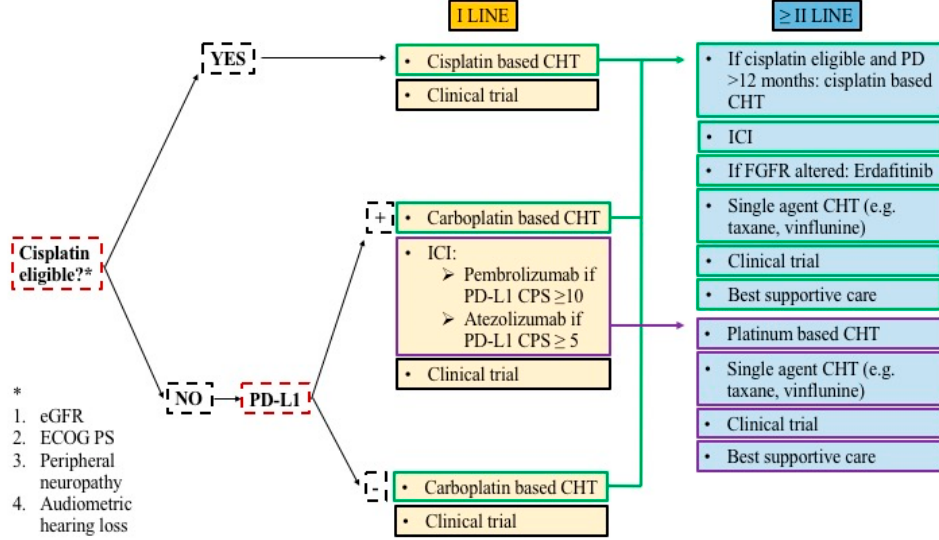
Figure 4. Current treatment algorithm for metastatic urothelial carcinoma. Based on cisplatin eligibility and PD-L1 positivity, patients are currently being treated as indicated in the figure. If cisplatin eligible (depending on eGFR, ECOG PS, peripheral neuropathy, audiometric hearing loss) patients should be treated with cisplatin-based chemotherapy. In cisplatin ineligible patients, the treatment changes according to PD-L1 positivity. If PD-L1 negative, patients should be treated with carboplatin-based chemotherapy. If PD-L1 positive, carboplatin-based chemotherapy or immunotherapy are the available options. Second and later lines of treatment depend on previous exposure to chemotherapy or immunotherapy. Enrollment in clinical trials should always be considered as a treatment option. CHT: chemotherapy. ICI: immune checkpoint inhibitor. PD: progressive disease. FGFR: fibroblast growth factor receptor. CPS: combined positive score. PD-L1: programmed death ligand-1. eGFR: estimated glomerular filtration rate. ECOG PS: eastern cooperative oncology group performance